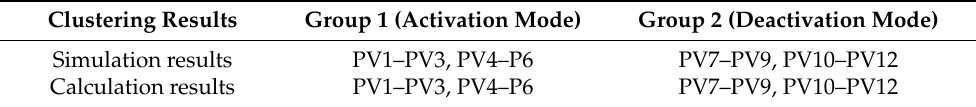
Table 1. The clustering results based on both simulation tests and theoretical calculation.